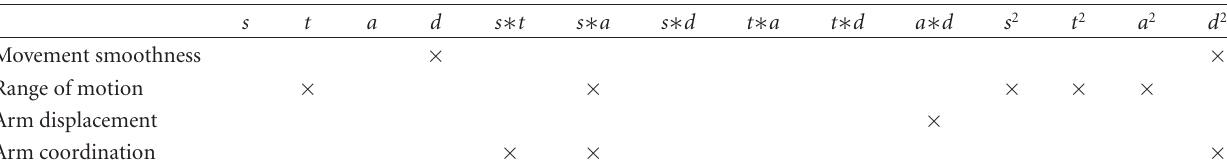
Table 2: Table of significances of the multiple regression analyses. Crosses indicate terms that have a significant contribution to the kinematic measure and thus are taken into account in our modeling purposes. s , t , a , and d refer to the training variables flying speed, turning speed, acceptance radius, and distance, respectively. See Table 3 for further details on the model coe ffi cients and related statistics.